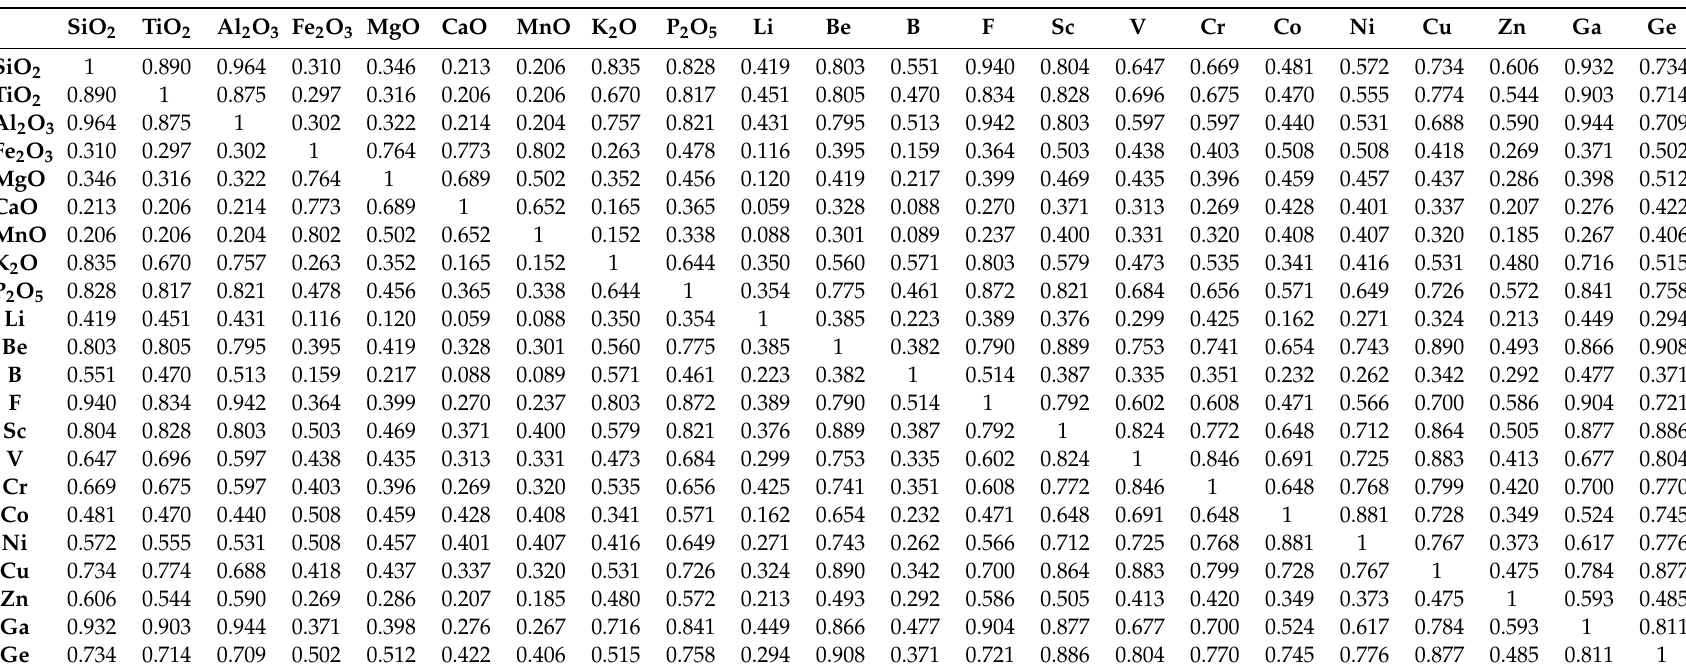
Table 1. Stability using Geboy’s approach on coal and ash basis (Datanhao